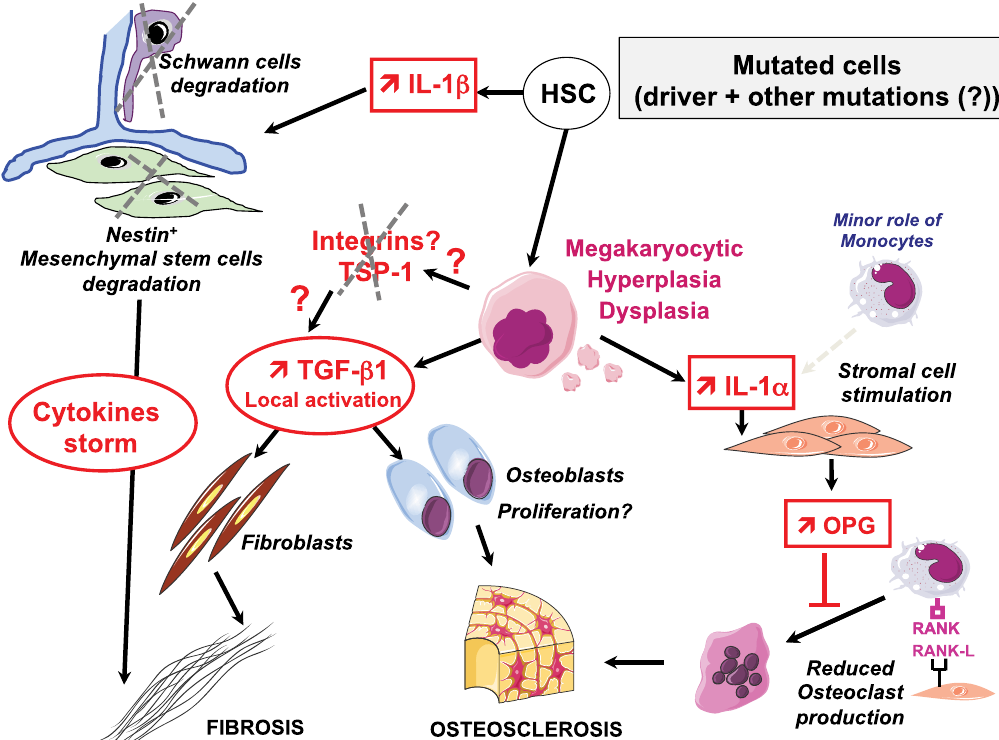
Figure 2. Role of microenvironment in the development of myelofibrosis. Mutated dysplastic megakaryocytes (MKs) are responsible for the myelofibrosis and osteoclerosis by inducing the release of (i) non-activated transforming growth factor β 1 (TGF β 1), which is activated in the bone marrow environment by a so far uncharacterized mechanism, possibly via integrins and matrix such as fibronectin and thrombospondin (TSP). Fibrosis begins around MKs associated with the proliferation of fibroblasts and eventually osteoblasts, (ii) interleukin-1 α (IL-1 α ) is released and induces osteoprotegerin (OPG) by t stromal cells, a decoy receptor that blocks osteoclast production. Mutated hematopoietic stem cells (HSCs) induce the increase in IL-1 α and the subsequent degradation of Schwann cells and mesenchymal stem cells, leading to fibrosis and osteosclerosis through cytokine storm and providing a favorable environment for the hematopoietic